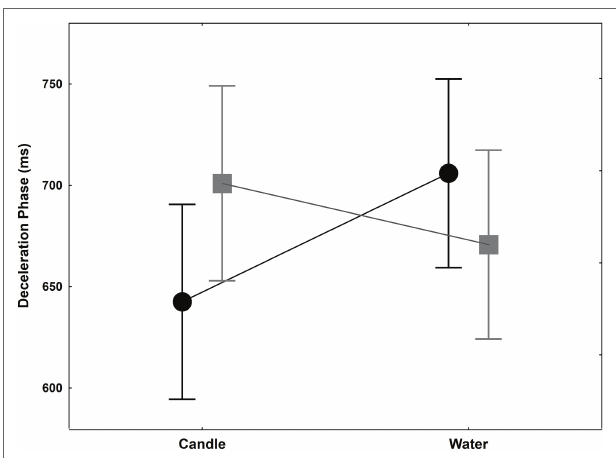
FIGURE 3 | Deceleration phase (ms) +/− SEM for controls (black circle) and thirsty groups (gray square) when they reached and grasped the candle or water glass. This phase is 30 ms shorter when thirsty group have to grasp the glass filled with water while it is lengthening in control